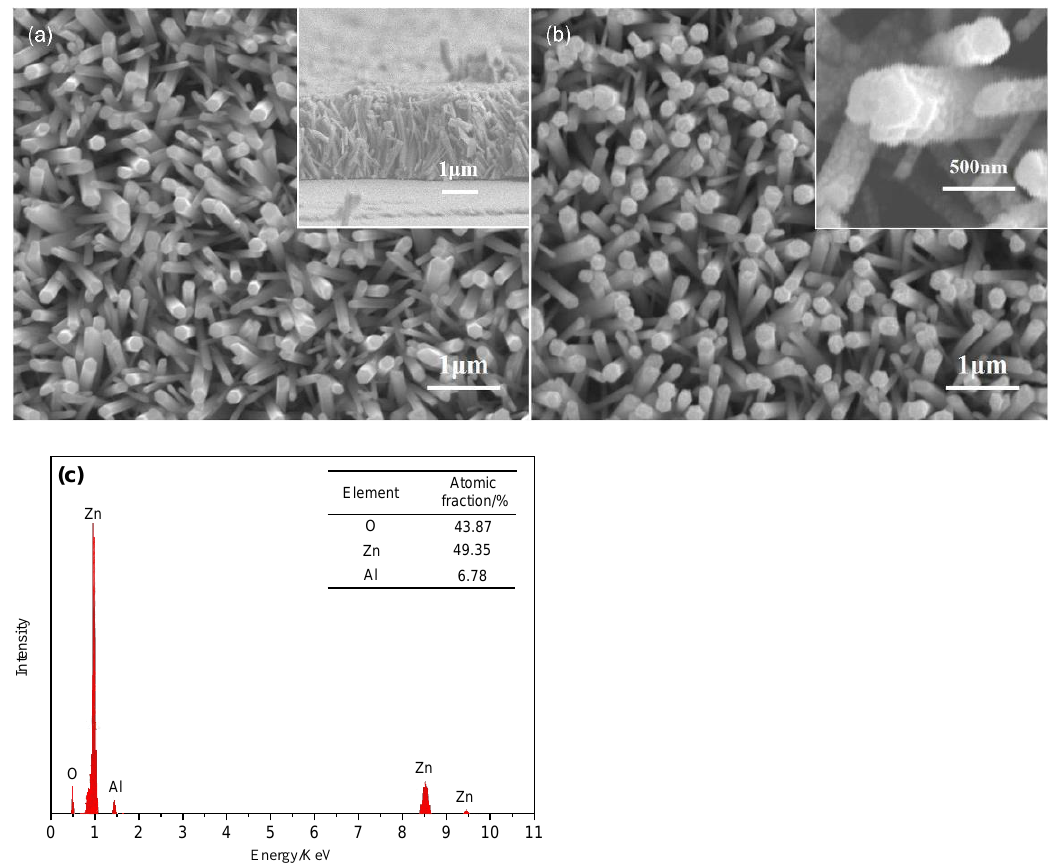
Figure 1. FE-SEM images of ZnO NRs decorated without ( a ) and with ( b ) Al NPs, and EDS of ZnO NRs decorated with Al NPs ( c ).